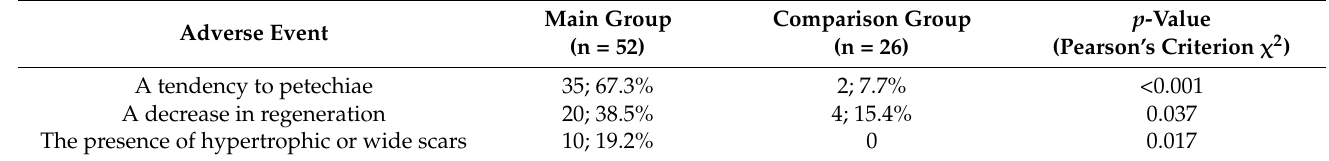
Table 3. Adverse events in patients of the main group and the comparison group.